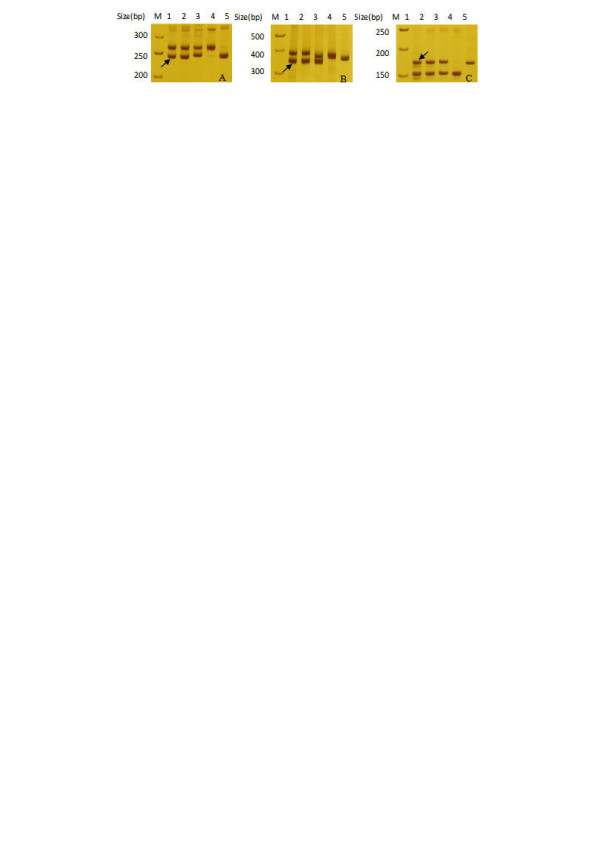
Identification of three BACs (AC187848, AC190263 and AC188140) belongings by amplified size analysis. Note: 1. G. hirsutum cv. Maxxa; 2. G. hirsutum acc. TM-1; 3. G. barbadense cv. Hai7124; 4. G. herbaceum var. africanum; 5. G. raimondii Arrow: amplified product with expected size from Maxxa. A: NAU6627 for AC187848 with expected size 247 bp. SSR tagging position was consistent with BAC clone belongings. B: NAU6202 for AC190263 with expected size 349 bp. BAC clone belongings is in homoeologous chromosome of SSR tagging position. C: NAU6465 for AC188140 with expected size 171 bp. BAC clone belongings is confirmed by comparing amplified product size in tetraploid with that in their diploid progenitors G. herbaceum and G. raimondii.